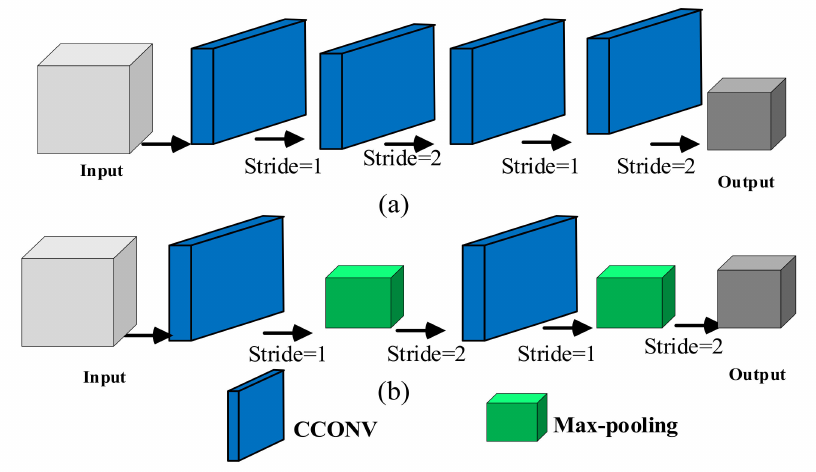
Figure 2. The structure of traditional shallow sampling module. ( a ) Convolution downsampling. ( b ) Max-pooling